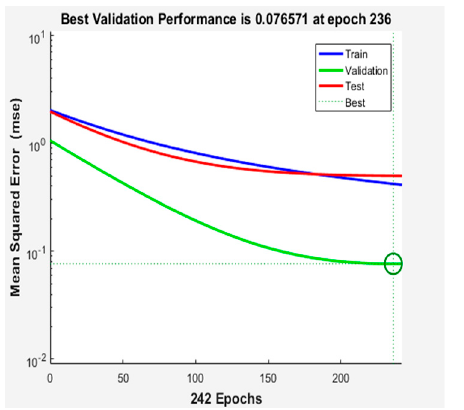
Figure 6. MSE value and R 2 results of PSO-ANN.